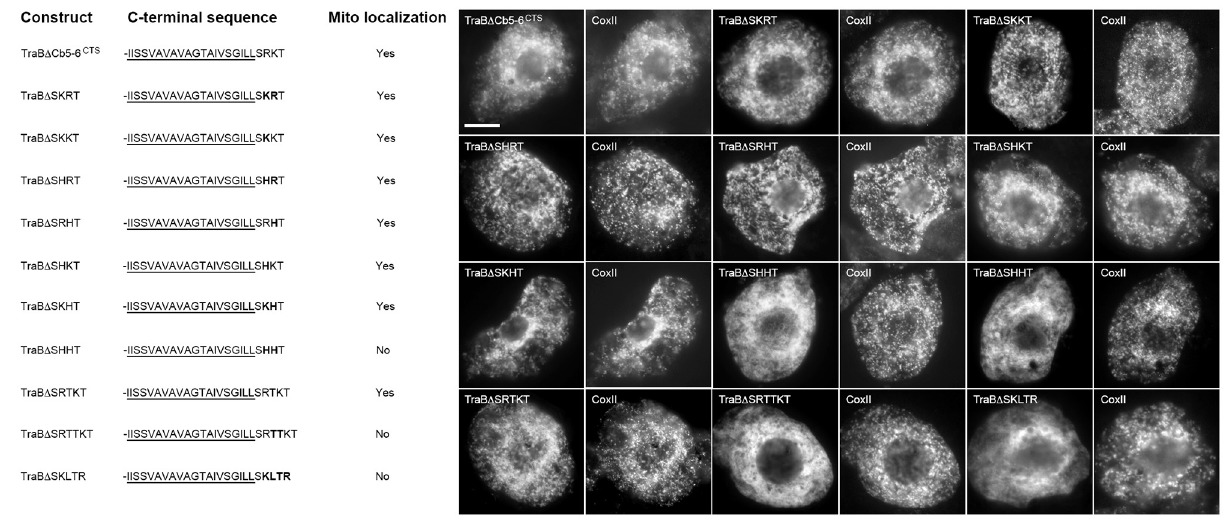
wild-type) Cb5-6 CTS; modified or additional amino acid residues inserted into the Cb5-6 CTS are bolded. Mitochondrial localization (indicated as “Yes” or “No”) was assessed based on colocalization (or lack thereof) of the expressed protein and endogenous mitochondrial CoxII. Shown on the right in both are representative immuno-epifluorescence micrographs illustrating the localization of the various constructs shown on the left . Each micrograph is labeled with the name of the expressed Myc-tagged TraB (cid:2) Cb5-6 CTS or CTS mutant version of TraB (cid:2) Cb5-6 CTS , or endogenous CoxII. Bar = 10 μ